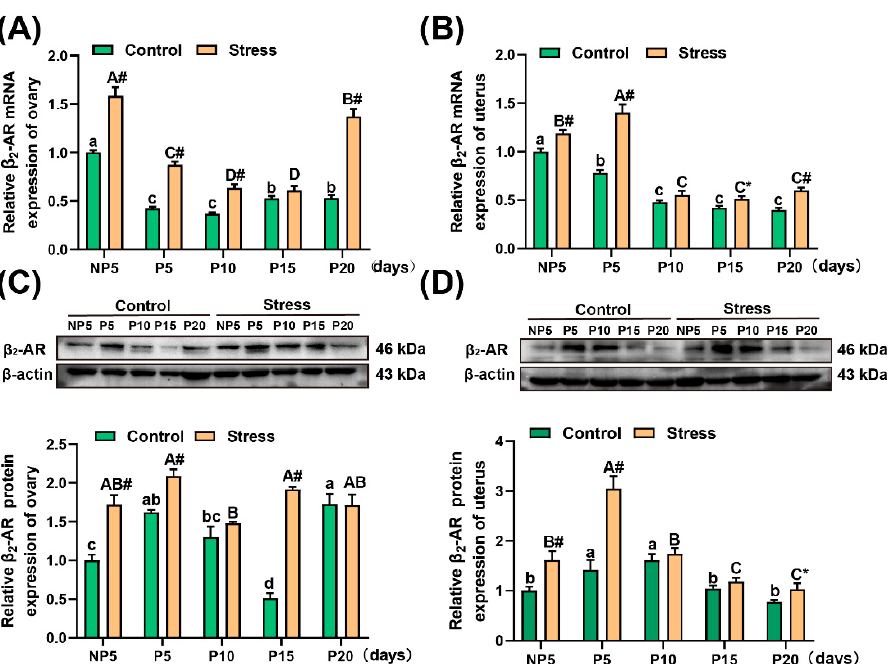
Figure 6. Effect of restraint stress on β 2 -AR in the uterus and ovary of pregnant mice. Oxidative stress led to a significant increase in mRNA levels and protein expression of β 2 -AR in the ovary ( A , C ) and uterus ( B , D ) of pregnant mice, suggesting that oxidative stress caused the body’s G-protein coupled receptors to be activated. The mRNA levels of β 2 -AR were detected by quantitative real-time polymerase chain reaction (qRT-PCR), and the protein level of β 2 -AR was measured by WB. The data are expressed as the mean ± SEM. Lowercase letters in the column (a, b, c, d) represent the differences between NP5 ( n = 10), P5 ( n = 10), P10 ( n = 10), P15 ( n = 10), and P20 ( n = 10) in the control group ( p < 0.05), and uppercase letters in the column (A, B, C and D) represent the differences between NP5 ( n = 10), P5 ( n = 10), P10 ( n = 10), P15 ( n = 10), and P20 ( n = 10) in the stress group ( p < 0.05). The value of NP1 was regard as 1 to be used as the base level of assessment. *p < 0.05 and #p < 0.01 were used to denote the significance of the stress group compared with the corresponding control group.